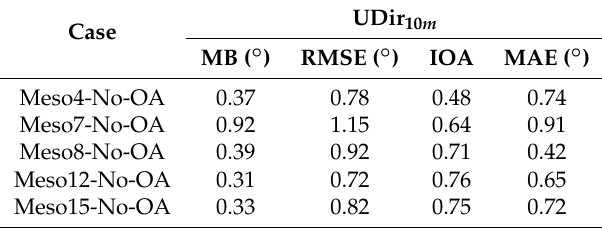
Table A5. Statistical measures for 10-m wind speed in mesoscale simulations performed without nudging. UDir 10 m Case